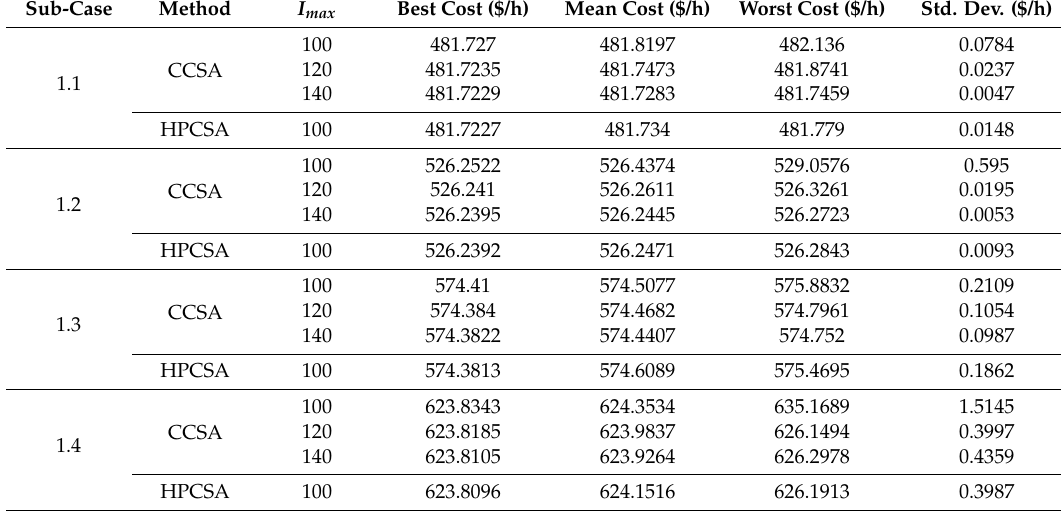
Table 12. Result comparisons between CCSA and HPCSA for case 1 with different I max of